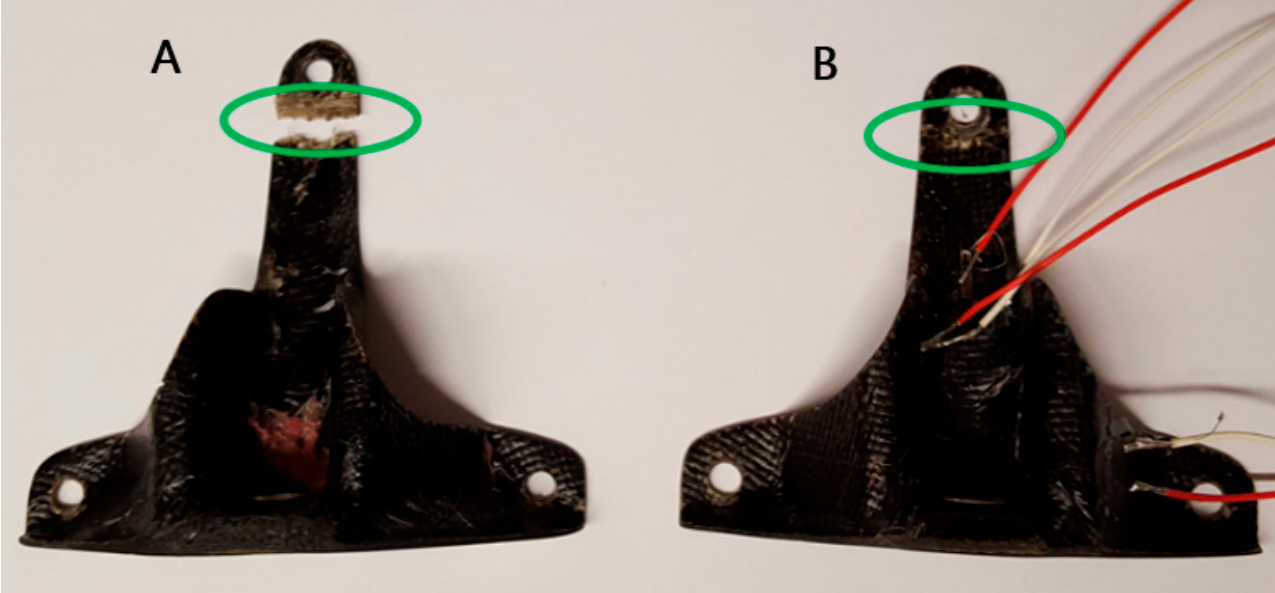
Figure 19. Failure of BFRP components, ( A ) and ( B ) .